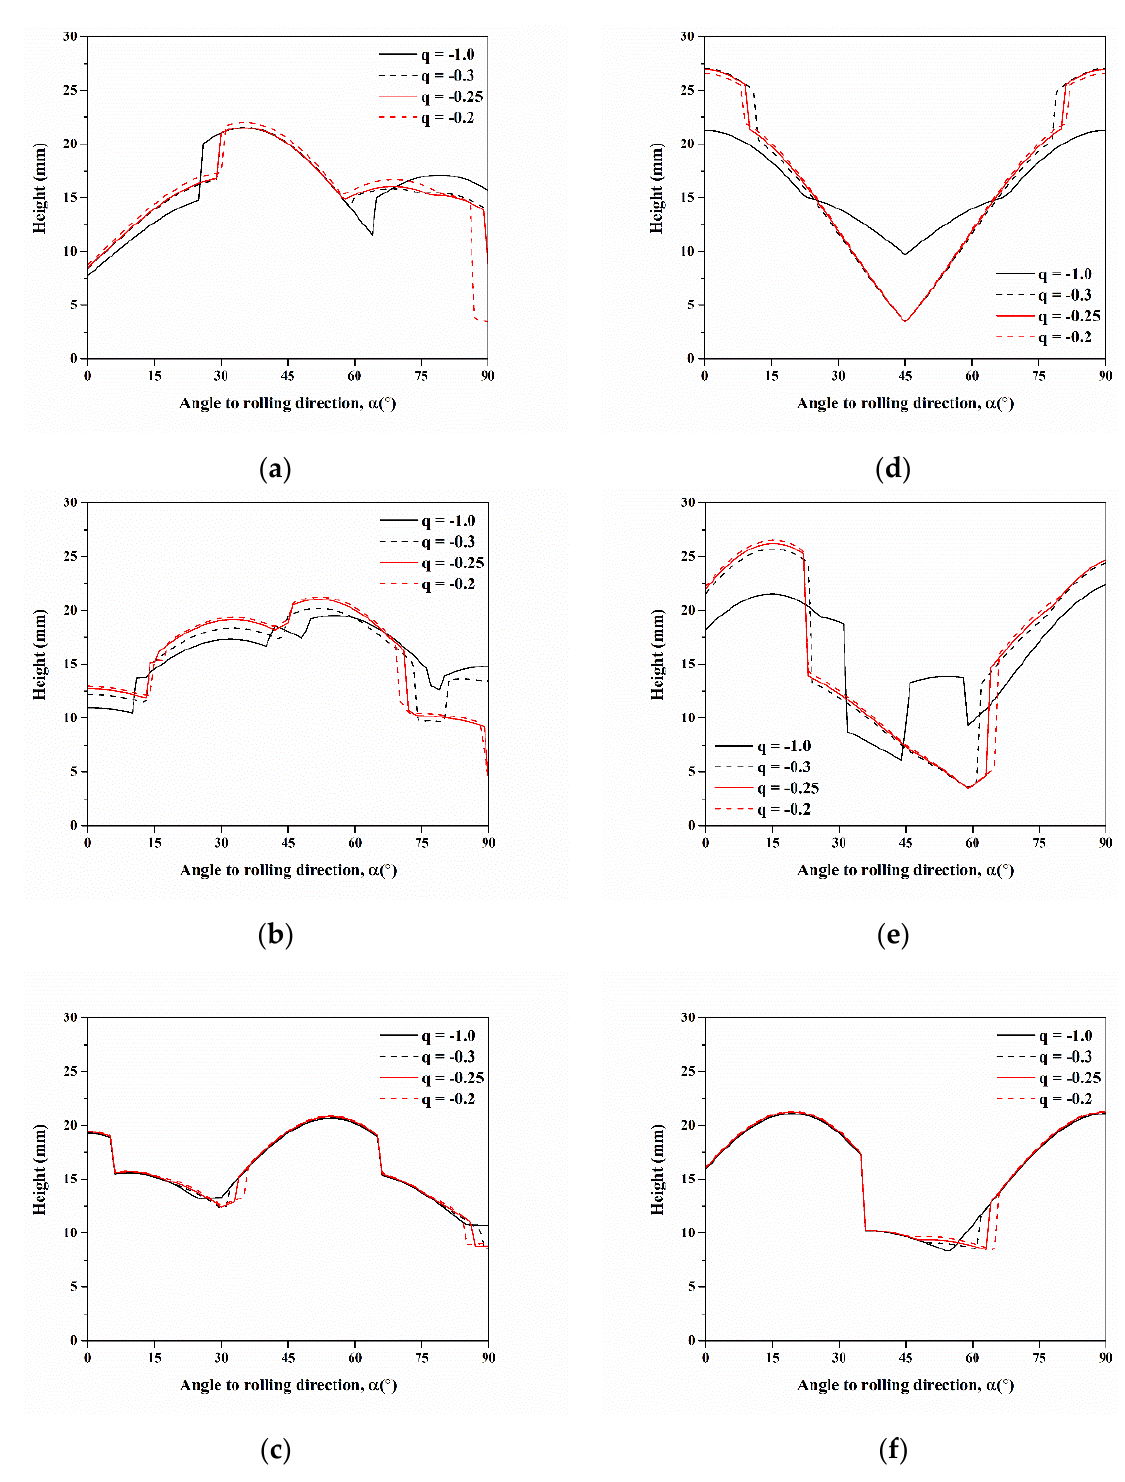
Figure 10. Cup height profiles as a function of the angle for texture components of ( a ) C, ( b ) S, ( c ) B, ( d ) Cube, ( e ) r-Cube, and ( f ) G predicted by assuming constant hardening exponent of 1 and stress ratio q from − 0.2 to − 1.0.